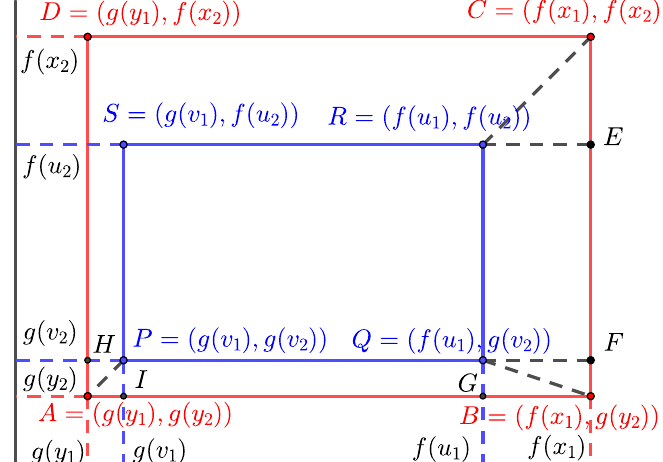
Figure 3. e ( F ( x , y ) , F ( u , v )) = max { A i : i = 1,2,3,4 }